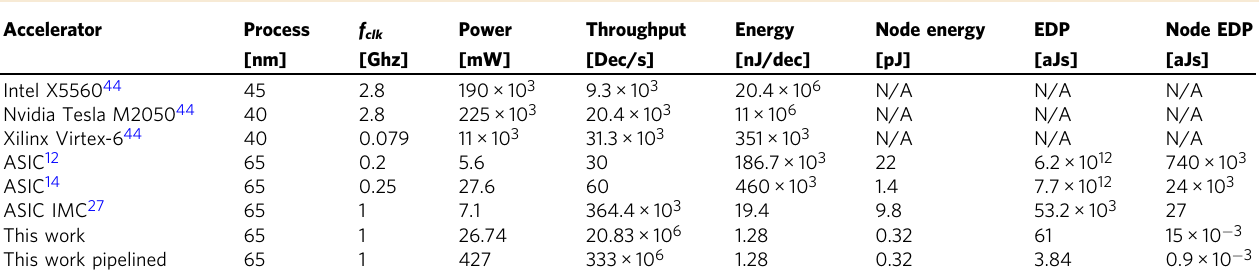
Table 1 Comparison of tree-based ML accelerators in literature with this work.